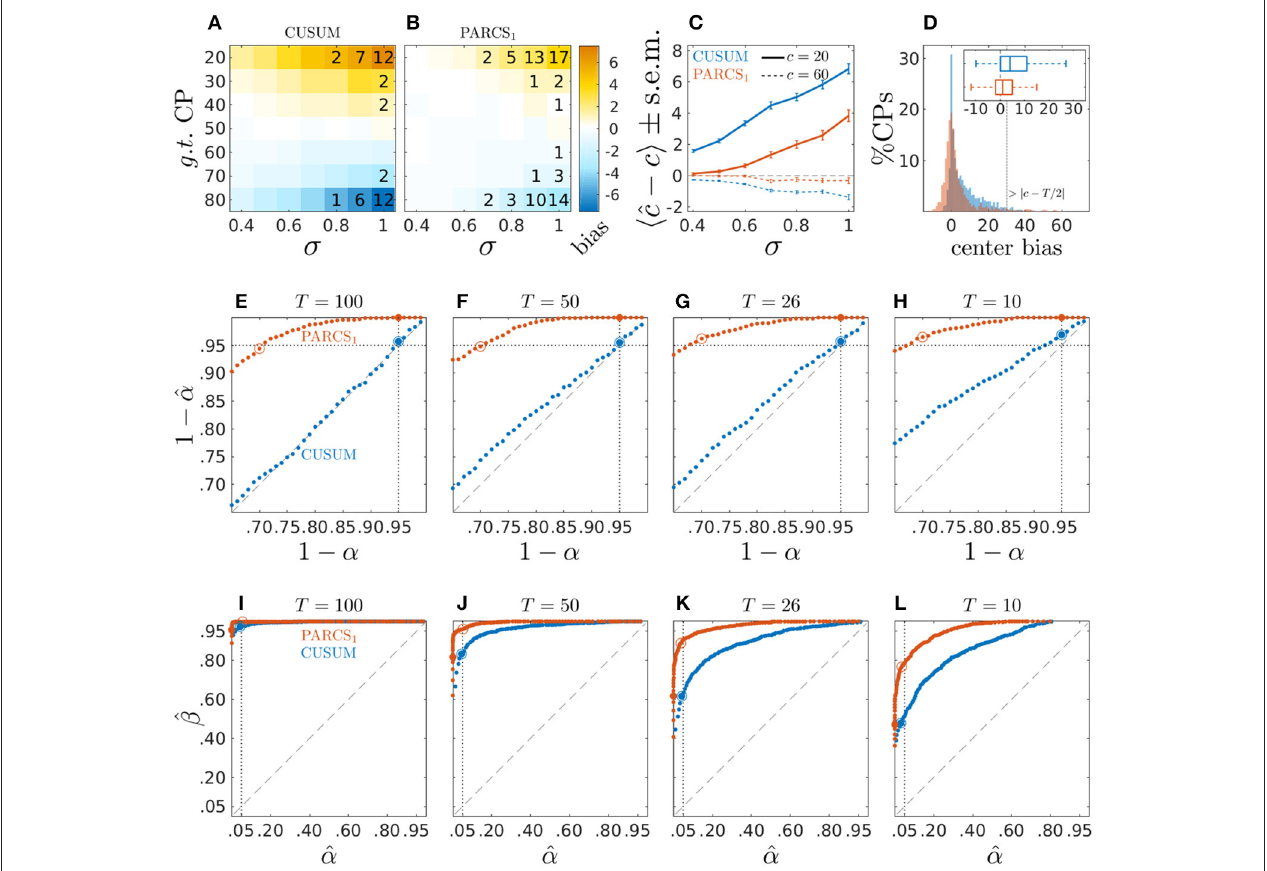
FIGURE 2 | Center bias in PARCS compared to CUSUM for temporally independent noise; (A,B) bias, hˆ c − c i , color-coded as indicated by the color bar; numbers indicate rounded type II error rates; (C) bias ± s.e.m. for c = 20 (solid) and c = 60 (dashed); (D) center bias distributions for c ∈ { 20,80 } and σ = 1.0; inset shows center bias distributions as boxplots that mark the median and first and third quartiles; whiskers include points within 1.5 times the interquartile range; outliers are excluded; (E–H) P-P plots comparing nominal ( x -axis) vs. factual ( y -axis) true H 0 rejection rates in time series of length (E) T = 100, (F) T = 50, (G) T = 26, and (H) T = 10; dotted vertical line, nominal α = 0.05; dotted horizontal line, factual ˆ α = 0.05; (I–L) ROC curves depicting false discovery rate (type I error rate; x -axis) versus power ( y -axis) for different series lengths as in (E–H) ; dotted vertical line, nominal α = 0.05; In (E–L) , larger filled circles indicate the empirical H 0 rejection rates at a nominal α = 0.05, and empty circles indicate where the factual ˆ α ≈